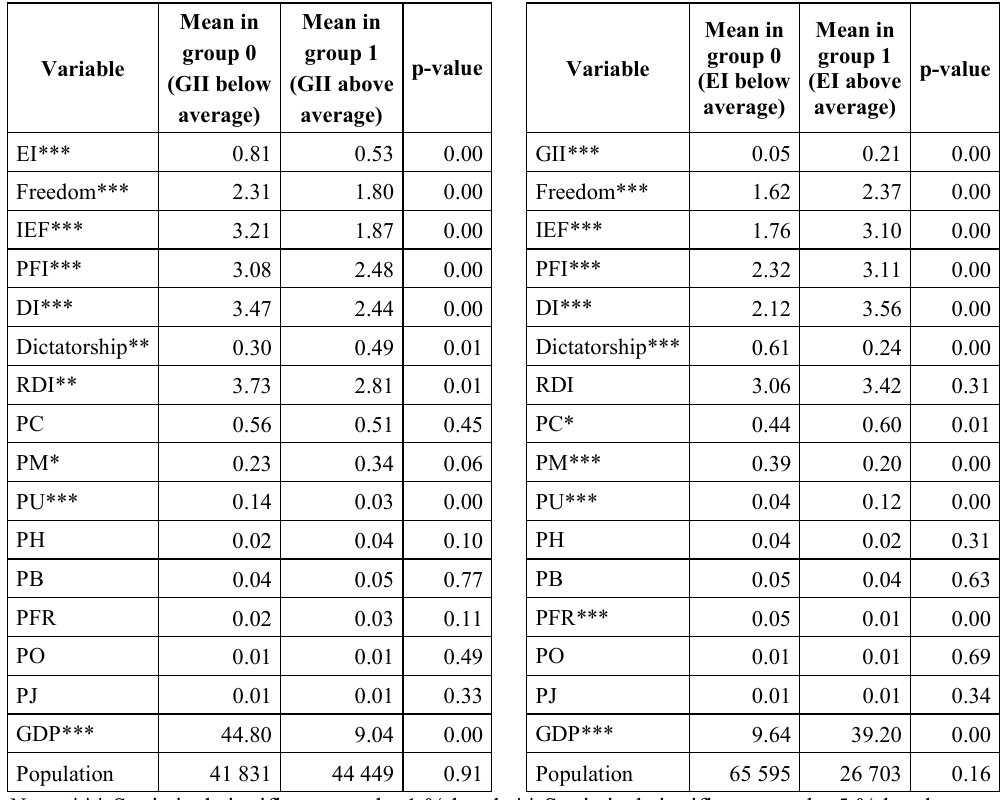
Table 3. Results of the Two-sample